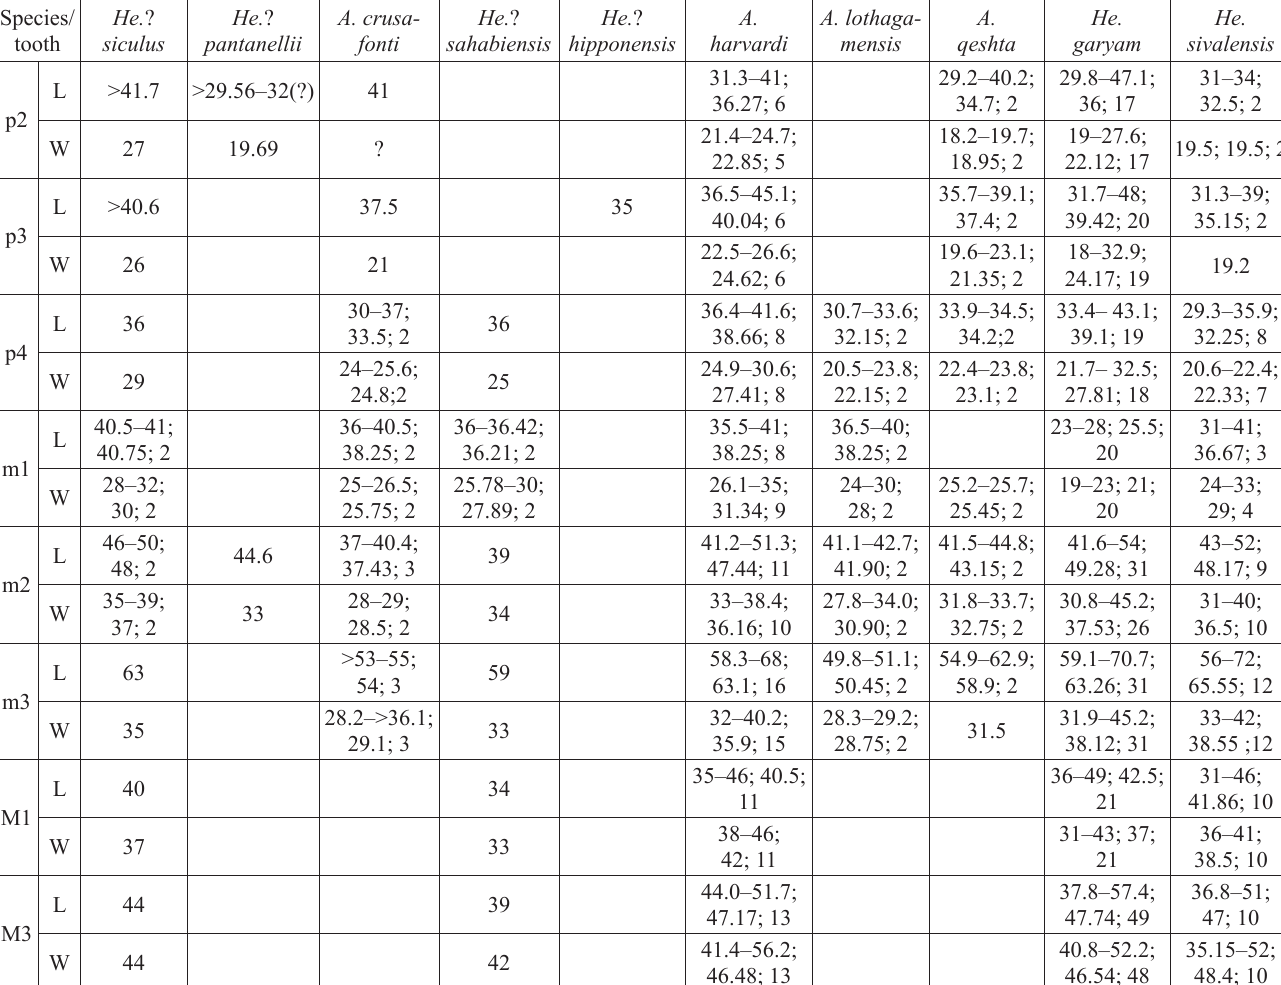
Table 1. Comparative dimensions of upper and lower teeth of Miocene hippopotamids (minimum–maximum dimension in mm; mean; number of specimens). Data for Hexaprotodon ? siculus from Seguenza (1902, 1907), Hooijer (1946, 1950); Archaeopotamus crusafonti from Aguirre (1963); Archaeopotamus crusafonti from Alcalá et al. (1986); Hexaprotodon ? sahabiensis from Gaziry (1987), Pavlakis (2008); Archaeopotamus harvardi from Coryndon (1977), Archaeopotamus lothagamensis from Weston (2000, 2003); Hexaprotodon garyam from Boisserie et al. (2005); Hexaprotodon sivalensis from De Visser (2008); Archaeopotamus qeshta from Boisserie et al. (2017). Values of Hexaprotodon ? pantanelli were measured at MSNAF (n.2828). The second lower premolar reported of Hexaprotodon ? pantanellii is partially broken and it was reported in Panta- nelli (1879) as 32 mm but the specimen measured at MSNAF is 29.56 mm; this tooth was probably broken after Pantanelli (1879). Abbreviations: L, length, W, width.